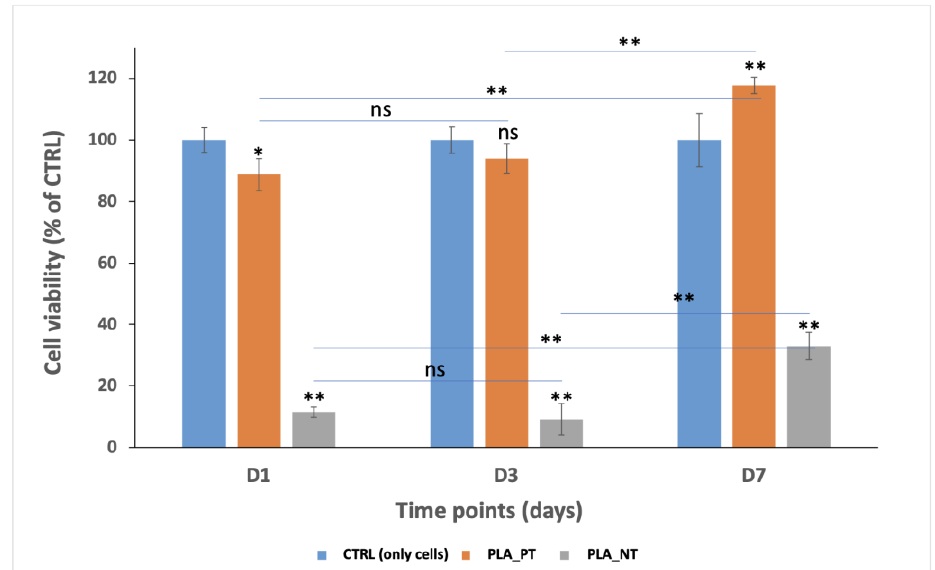
Figure 5. Cell viability (MTT assay) after 1, 3, and 7 days (D1, D3 and D7) of hFOB cells culture on PLA_NT and PLA_PT scaffolds compared to the control (CTRL, only cells). Data are reported as mean ± standard deviation obtained on 3 scaffolds. * p < 0.05 and ** p < 0.01 show significant differences between the different time points and scaffolds, as reported by the Holm post-hoc test. ns = not significant.